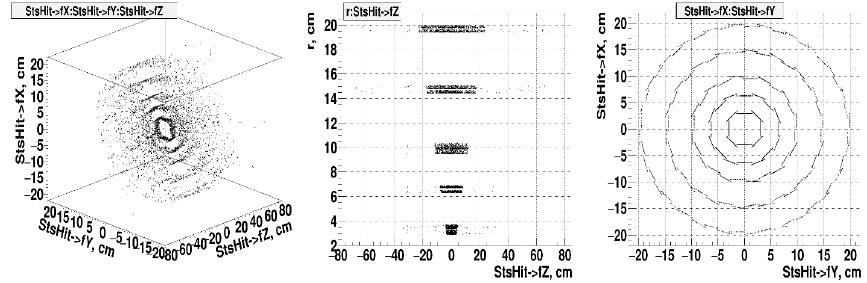
Figure 3. Hits in ITS: left) X vs Y vs Z view; middle) radius in transverse plane vs Z view; right) X vs Y view. Here Z-axis is along the beam direction, X-axis is horizontal and orthogonal to the